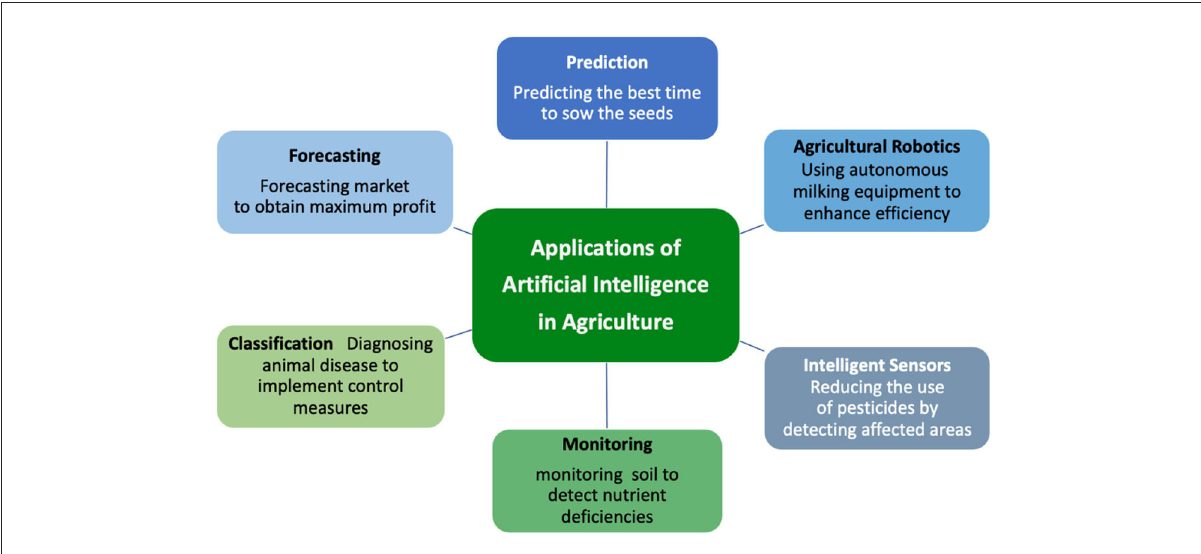
FIGURE1 Artificial intelligence applications in digital